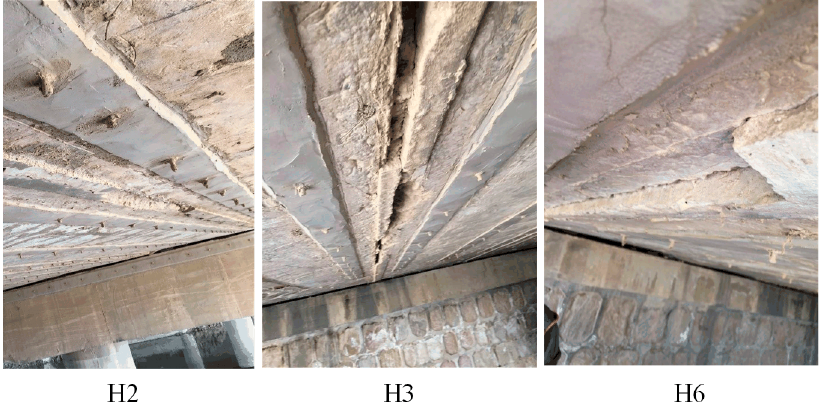
Figure 11. Surface damage of the joints.